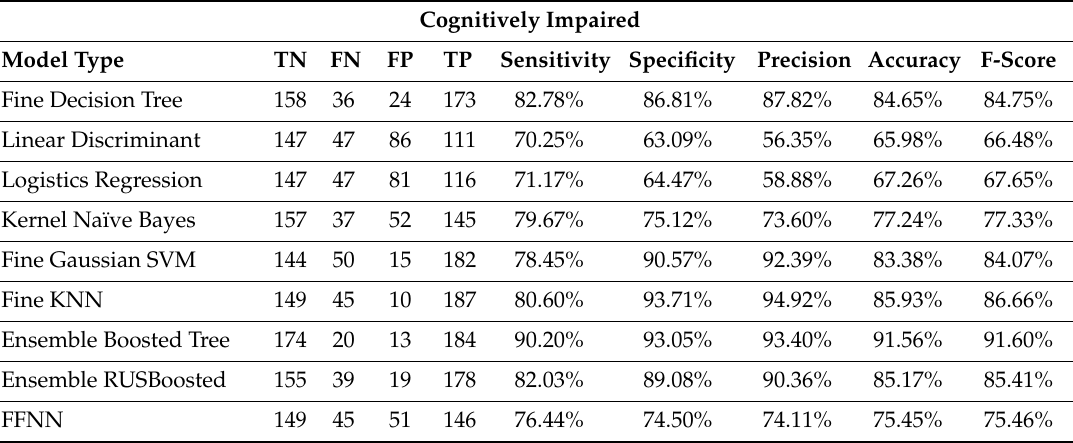
Table 4. Train the model with balanced data using SMOTE.